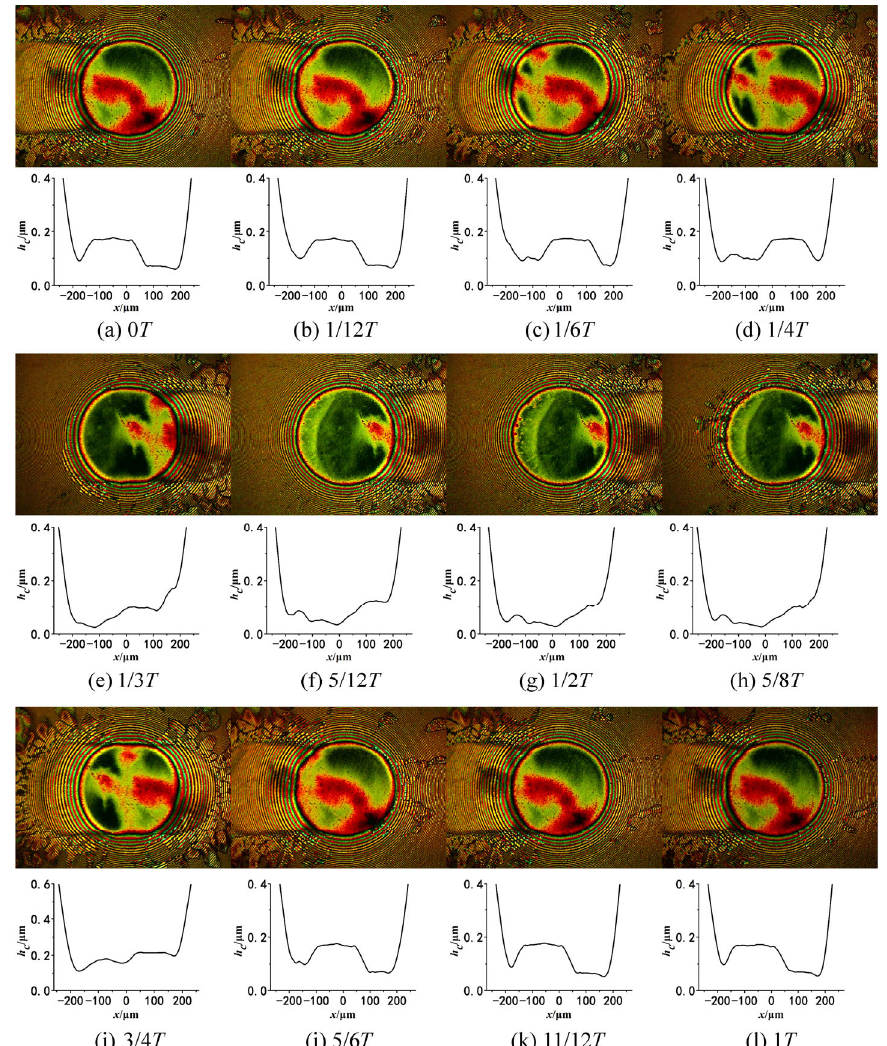
Fig. 17 Interferograms and midsection film thickness during 1,000th cycle under pure rolling reciprocating motion ( v max = 0.01 m/s, w = 50 N, T = 0.3 s, L = 0.75 mm).